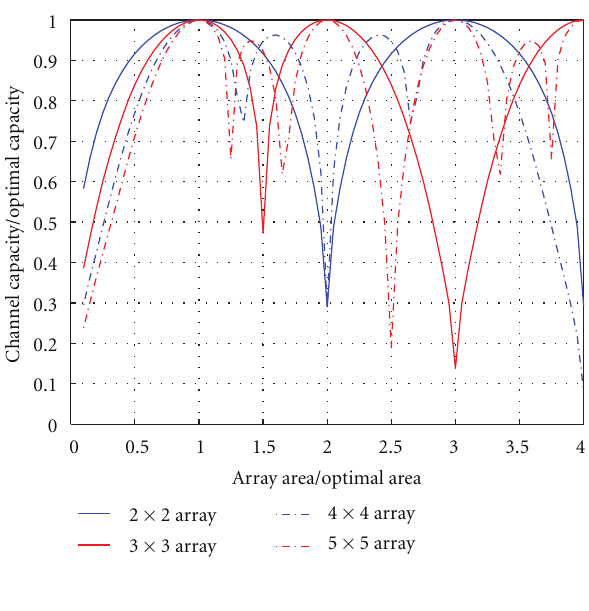
Figure 4: Channel capacity versus antenna array area.